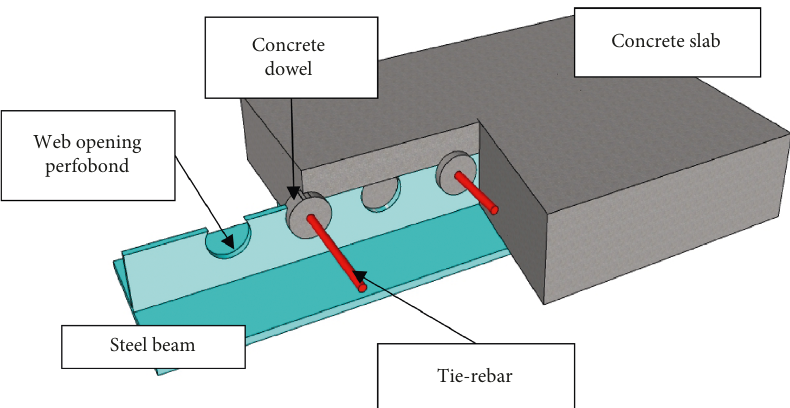
Figure 14: Configuration of the steel beam and perfobond-like shear